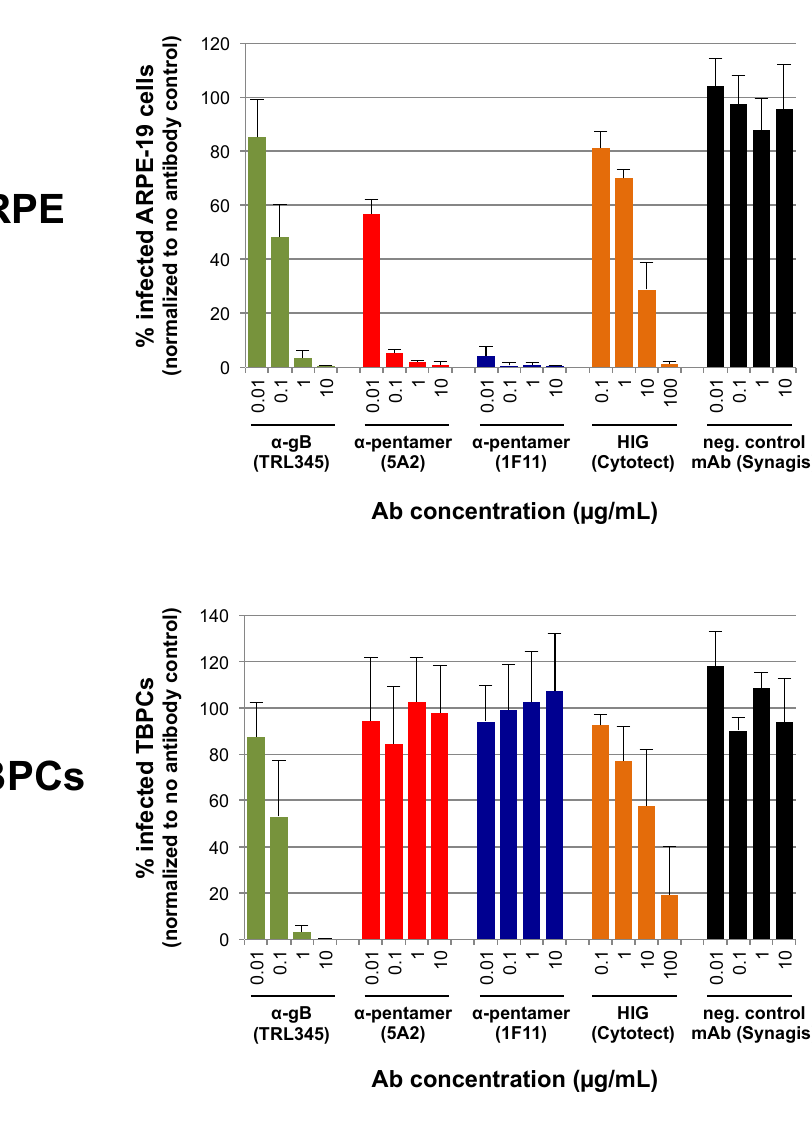
Figure 5. Infection of TBPCs is blocked by a mAb to gB but not mAbs to the pentamer complex. ( A ) VR1814 (MOI 0.01) was pre-incubated with medium alone, a serial log dilution of the indicated mAb (0.01–10 µg/mL) or HIG (0.1–100 µg/mL). Virus-antibody mixtures were then applied to ARPE-19 cells. At 2 dpi, IE1 was immunostained and numbers of infected cells were counted. Data were normalized to the no Ab control. Error bars indicate standard deviation. ( B ) TBPCs were incubated with virus-antibody mixtures and analyzed as described for panel A